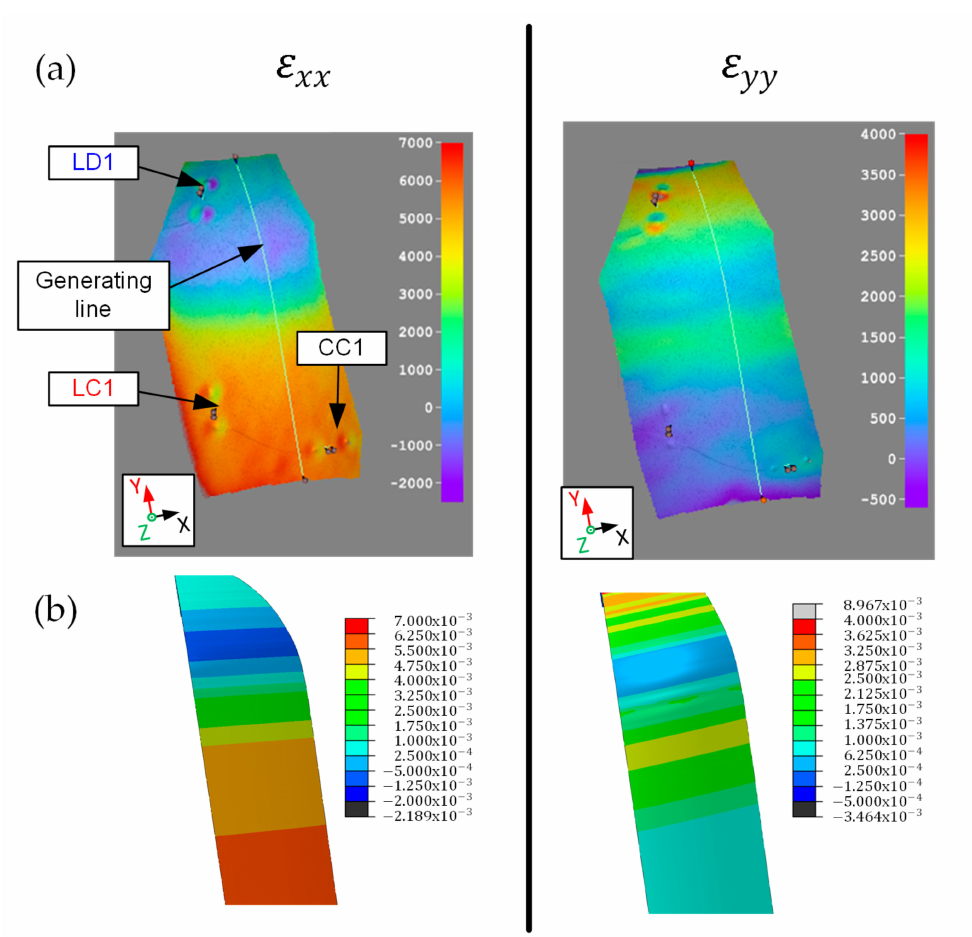
Figure 12. Along with the strain field obtained from the DIC method, the results from FEM are shown.